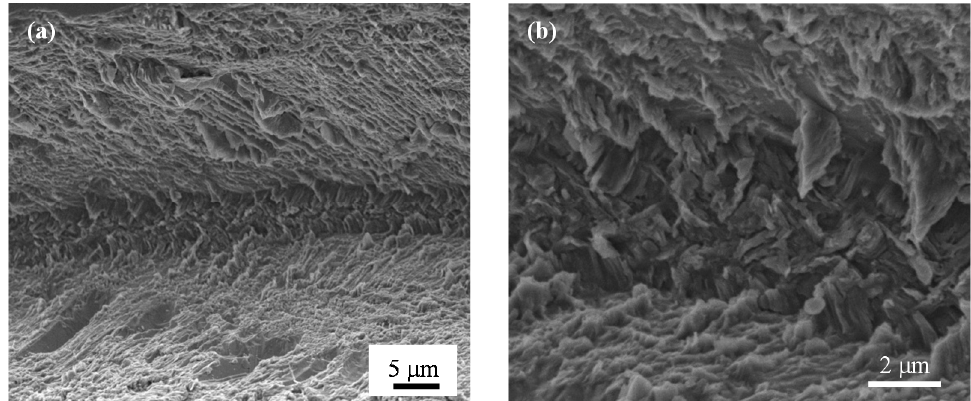
Figure 4. SEM images of the grooves formed by the reverse irradiation of the HPHT sample at a fluence of 9.1 J/cm 2 showing ( a ) the groove bottom; ( b ) at a larger magnification.